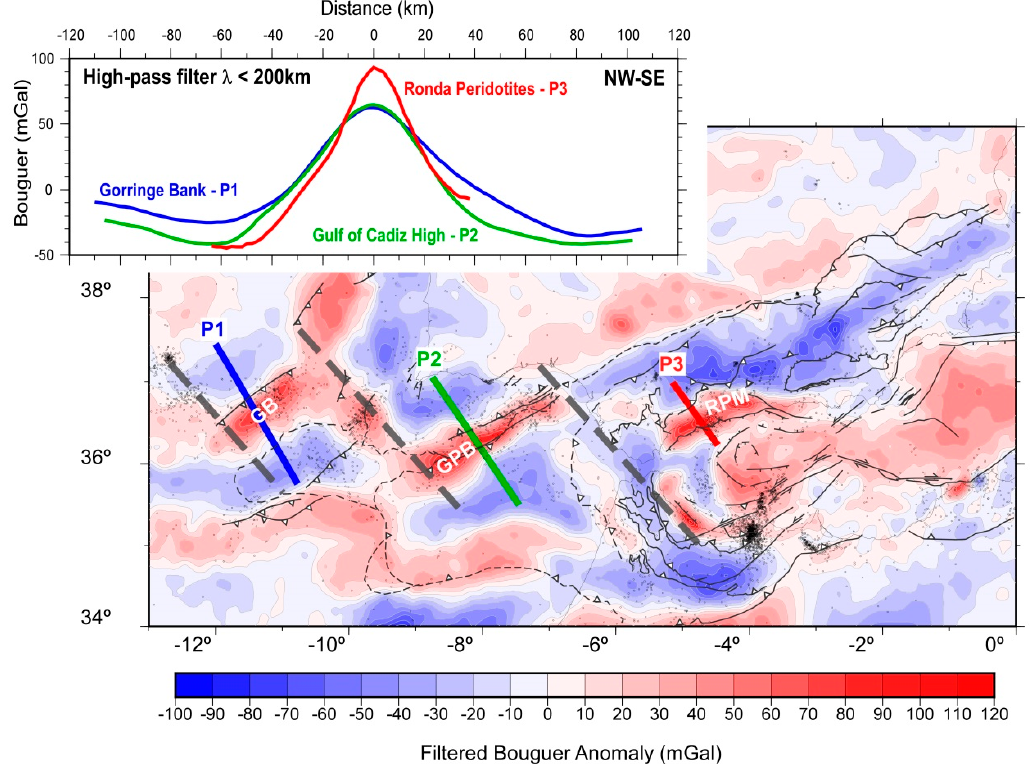
Figure 3. Filtered Bouguer gravity anomaly map of the Iberia–Africa plate boundary region after applying a high-pass filter of 200 km wavelength to the total Bouguer anomaly map shown in Figure 2. Profiles P-1 to P-3 indicate the locations of the modeled cross sections shown in Figure 4 with gravity values displayed in the inset. Tectonic background as in Figure 1. Thick discontinuous gray lines indicate the suggested transform zones separating the margin segments. GB: Gorringe Bank; GPB: Guadalquivir–Portimao Bank; RPM: Ronda Peridotite Massif. Dots denote epicenter locations